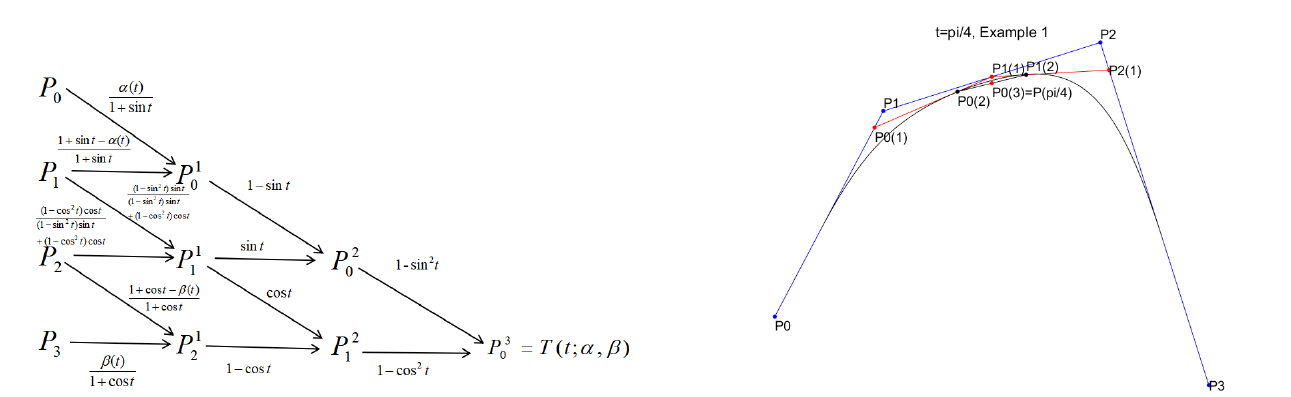
( a ) The structure of the corner cutting algorithm.